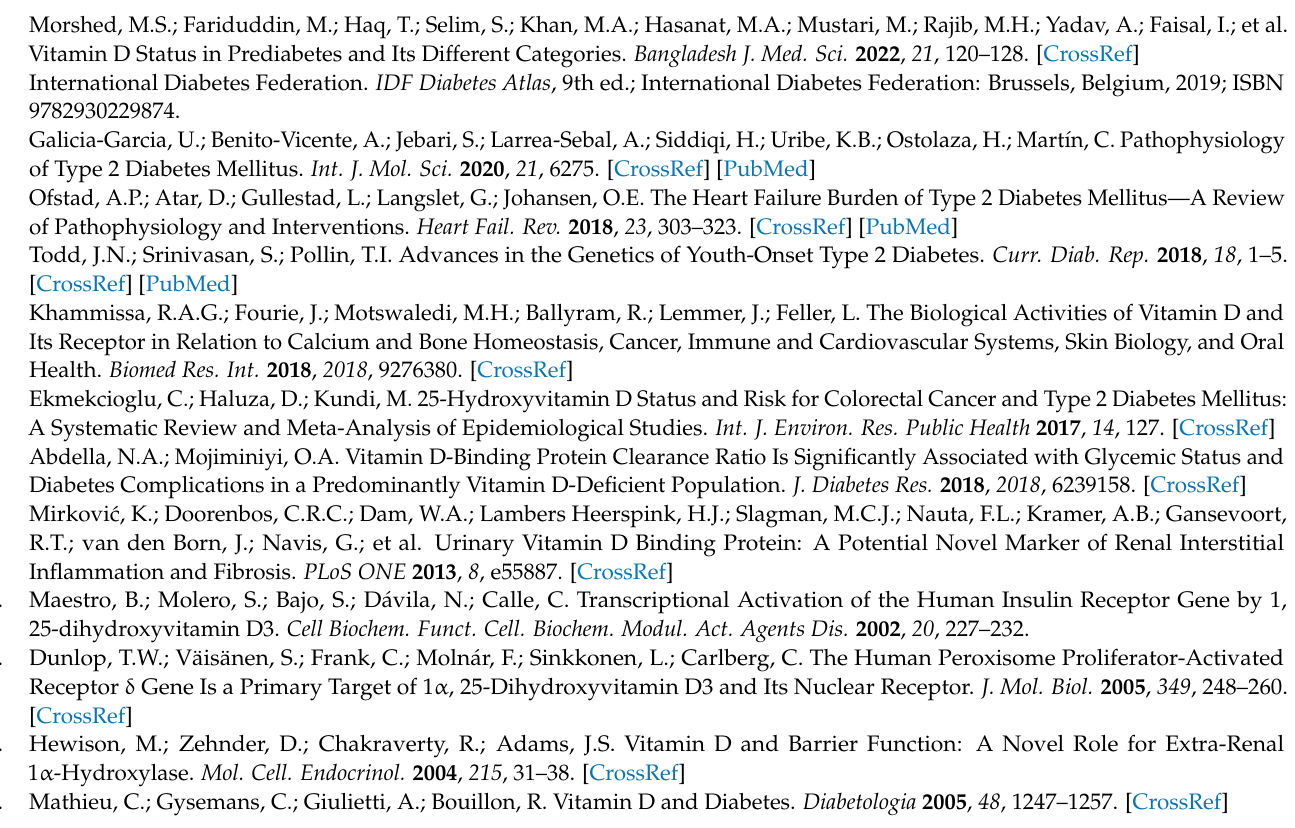
Table S3: Comparison between Study Groups based on rs228570; Table S4: Comparison between Study Groups based on rs1644410; Table S5: Comparison between Study Groups based on rs7975232; Table S6: Comparison between Study Groups based on Vitamin D Status; Table S7: Insulin Status Among the Study Groups; Table S8: Comparison between Study Groups based on Fasting Insulin; Figure S1: ROC curve of Fasting